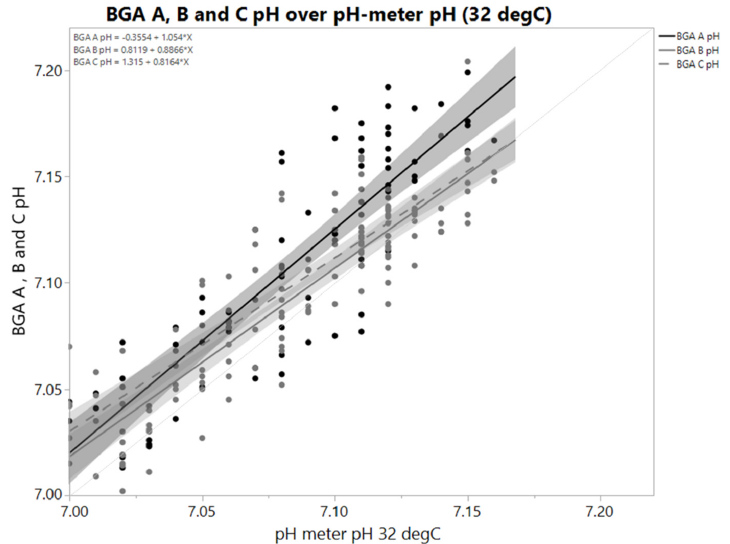
Figure 1. pH values derived by a pH-meter and three blood gas analyzers A, B and C in identical samples; where B and C are two comparable devices. X-axis shows pH-meter value. Sample temperature for pH meter was controlled at 32 ◦ C ± 2 ◦ C. Samples came from eight parallel bioreactor runs (N = 72). Temperature of measurement chamber of all blood gas analyzers was 37 ◦ C. Grey areas are 95% confidence intervals of the linear regression. pH decreases with increasing temperature, so difference between BGA pH and pH-meter cannot be explained by a temperature effect. Slopes and offsets both differ. That means difference depends on either actual pH or sample properties that correlate with pH. Spread of differences is high. A single pH value obviously may not contain required information to justify a readjustment